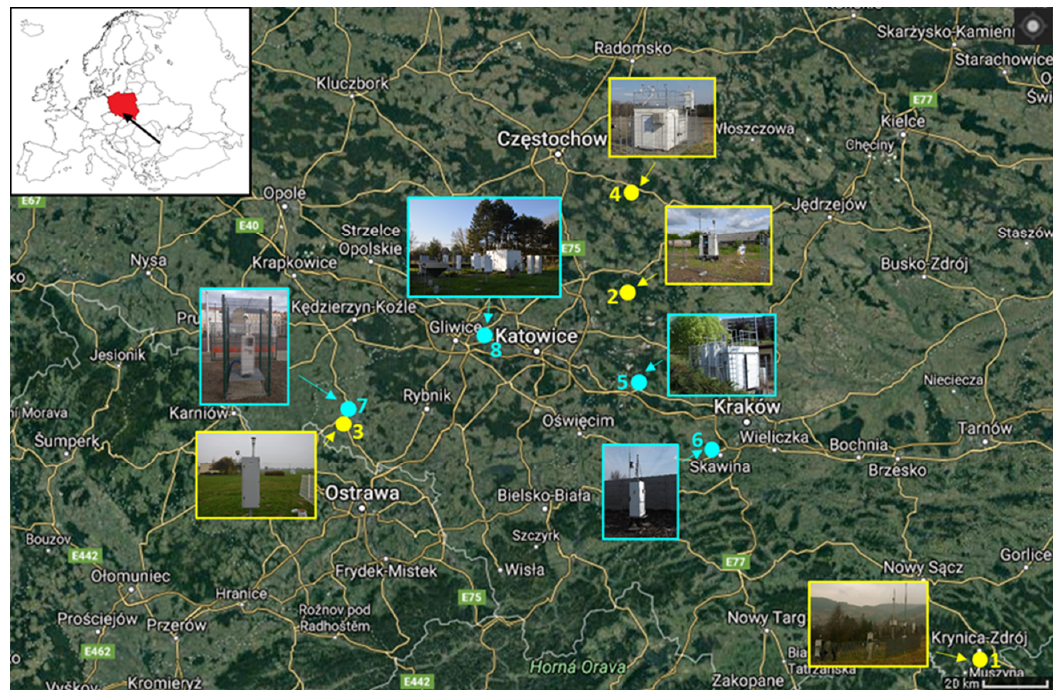
Figure 1. Location of the study area and measurement stations (1–8 in figure) selected for research. Source: Google Maps; photos: own collection and [41].